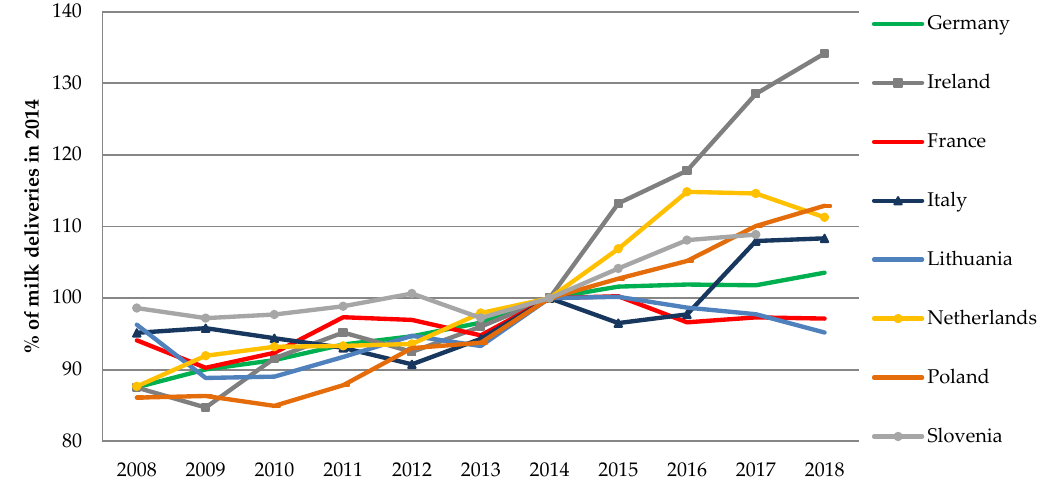
Figure 2. Dynamics of raw cows’ milk delivered to dairies in selected EU countries in 2004 to 2018; deliveries in 2014 are set at 100%. Source: EUROSTAT Database [1].